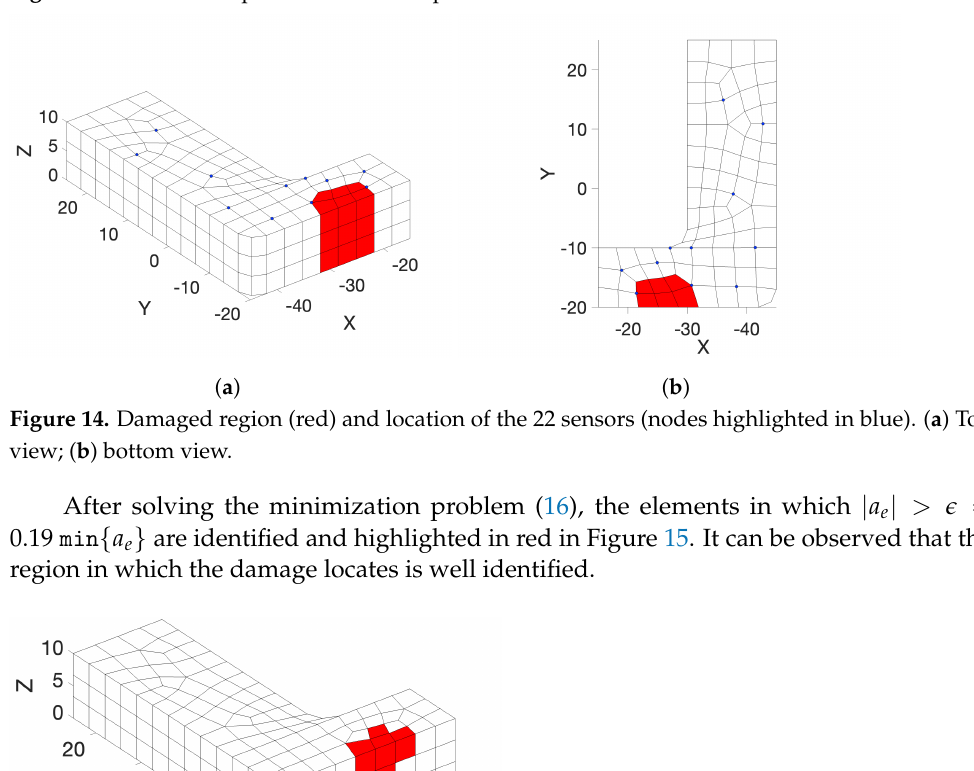
Figure 13. Schematic representation of the problem.